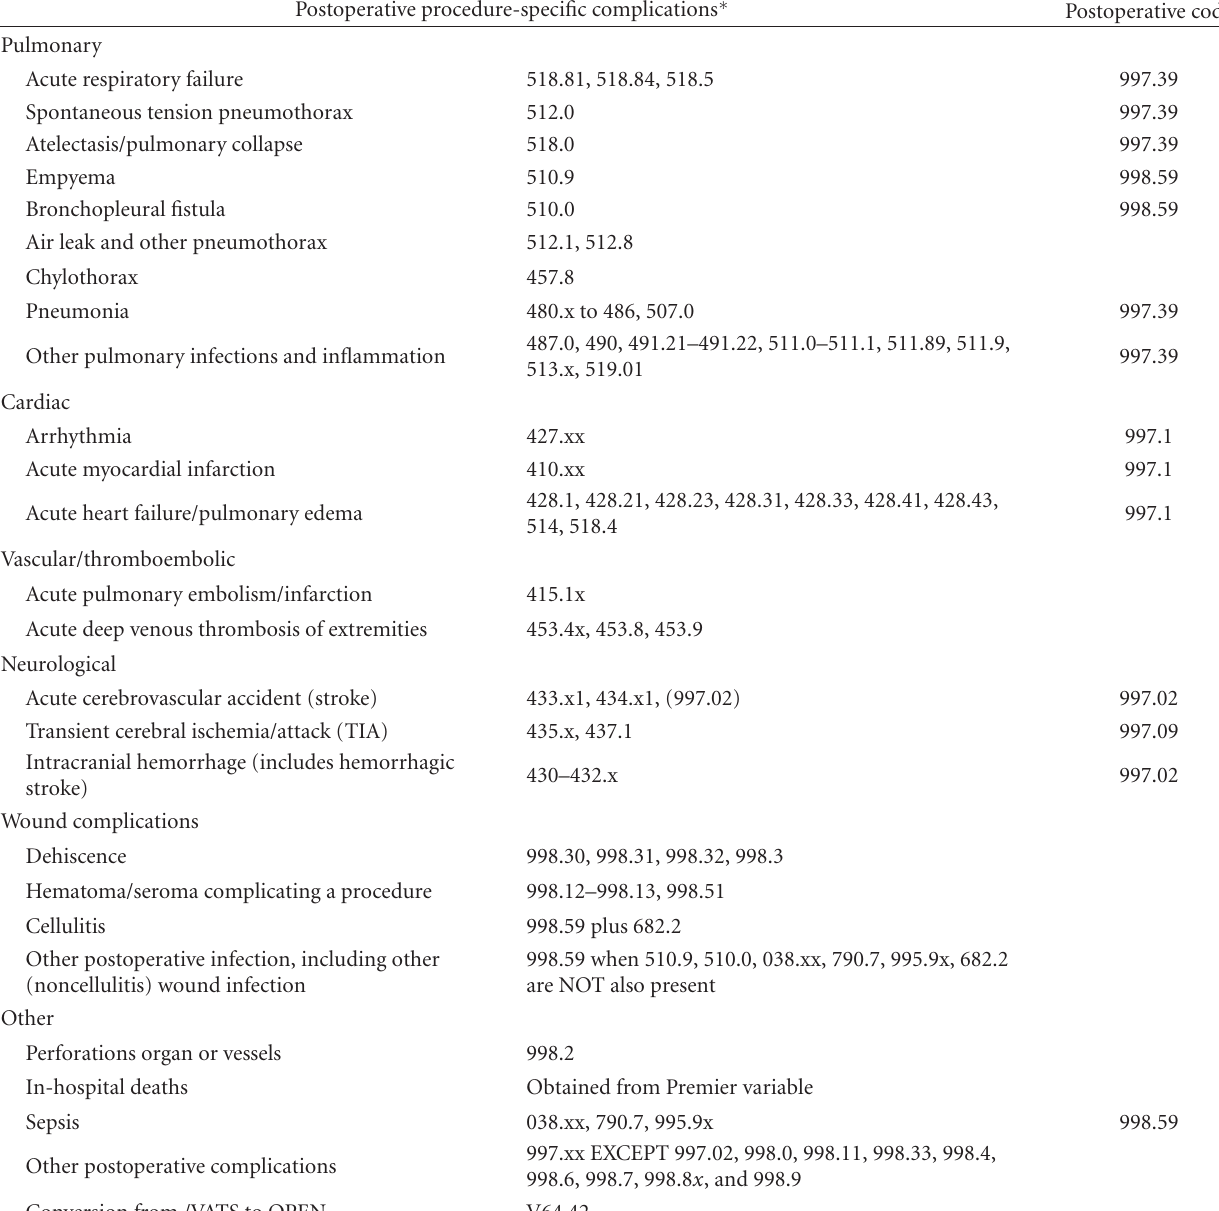
Table 9: Postoperative procedure-specific